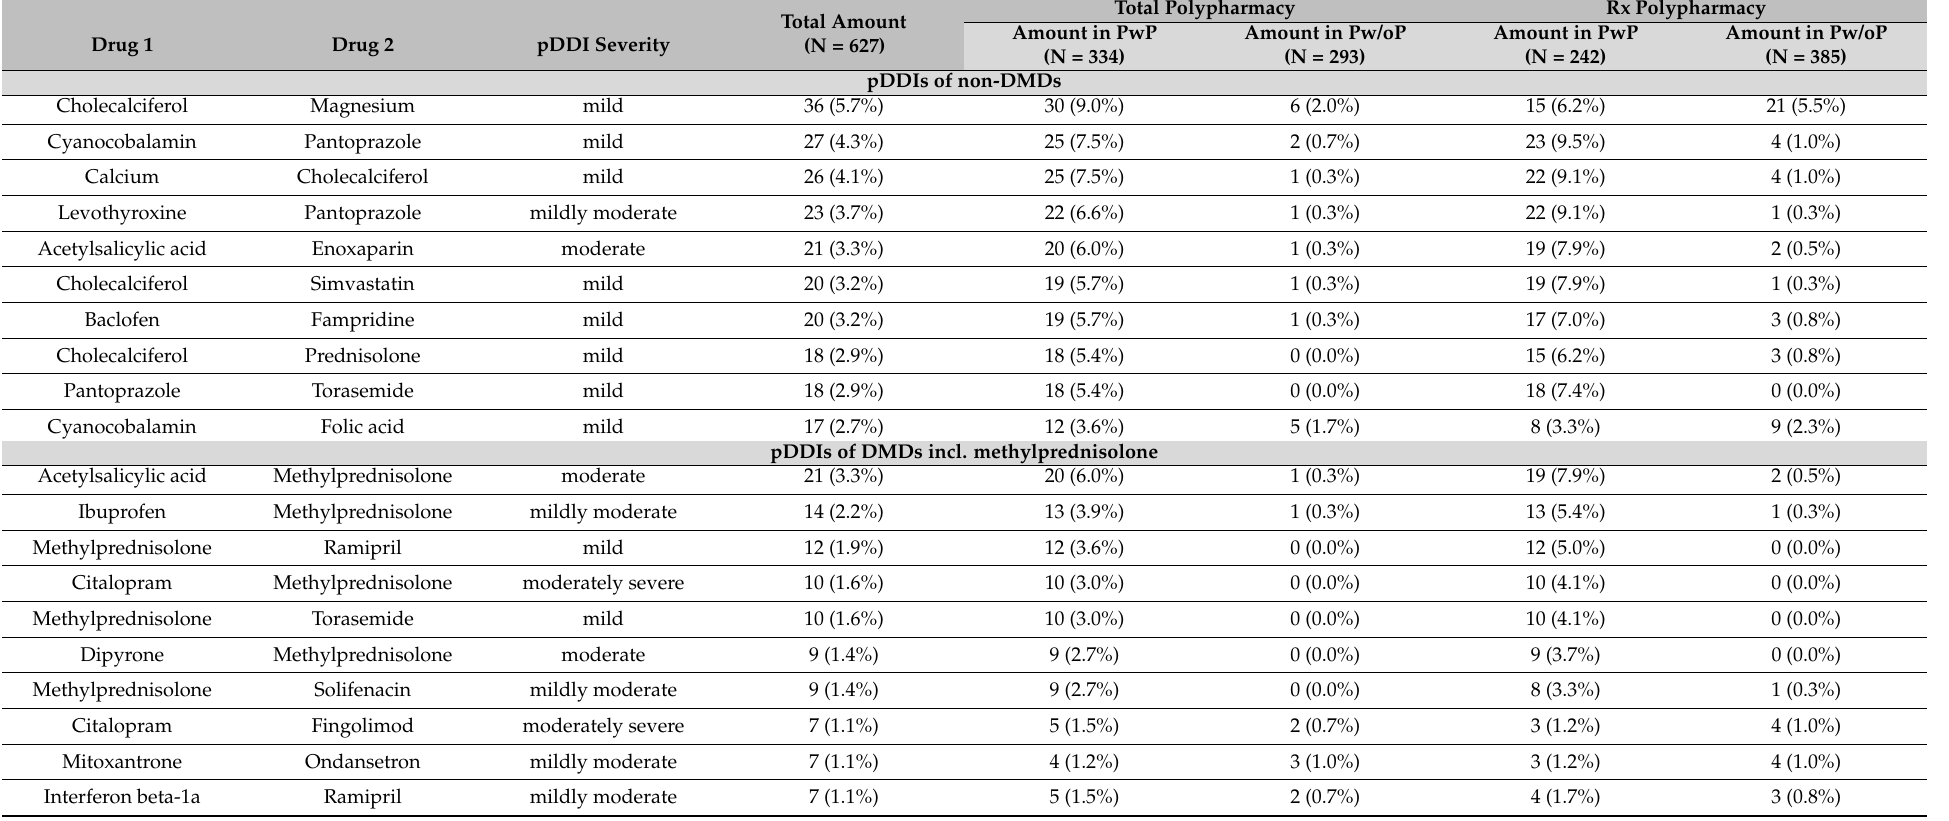
Table 6. The most common pDDIs in patients with